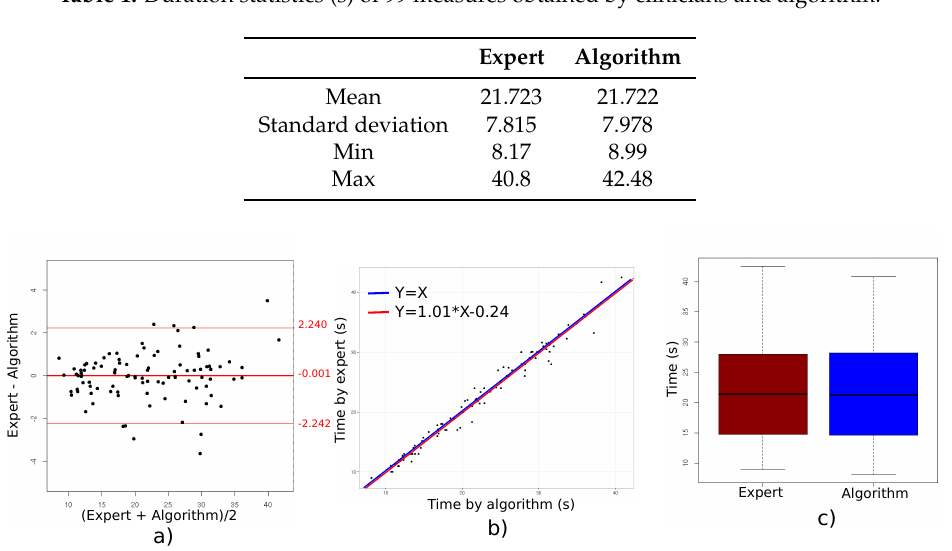
Table 1. Duration statistics (s) of 99 measures obtained by clinicians and algorithm.